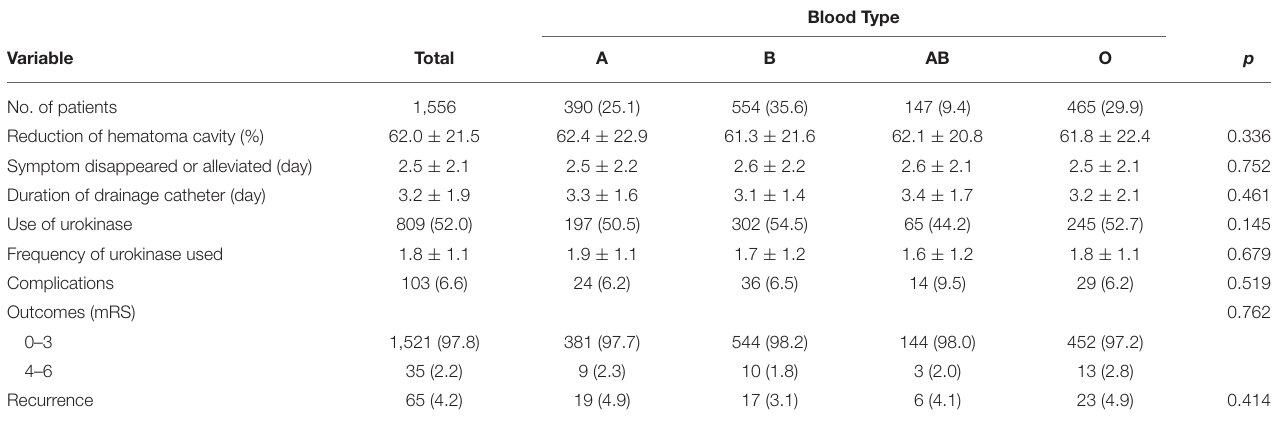
TABLE 3 | Postoperative clinical features of 1,556 patients with CSDH.